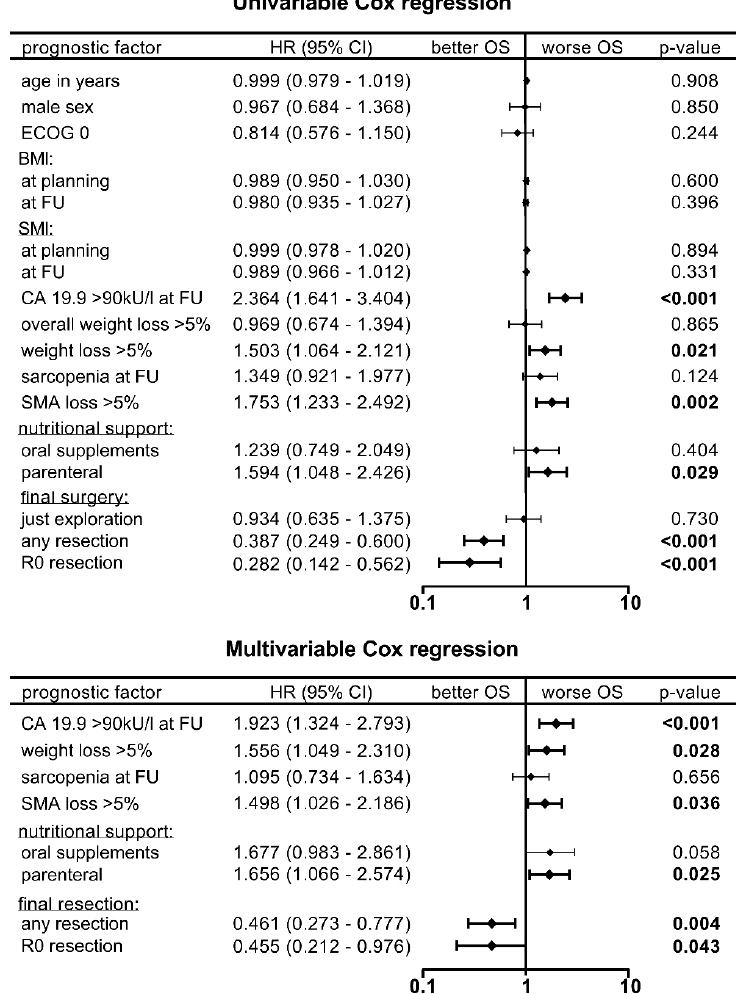
Figure 5. Uni- and multivariable Cox regression analysis, with hazard ratios (HR) and a 95% confidence interval (CI). Factors with p -values < 0.15 in univariable cox regression were selected for multivariable analysis.